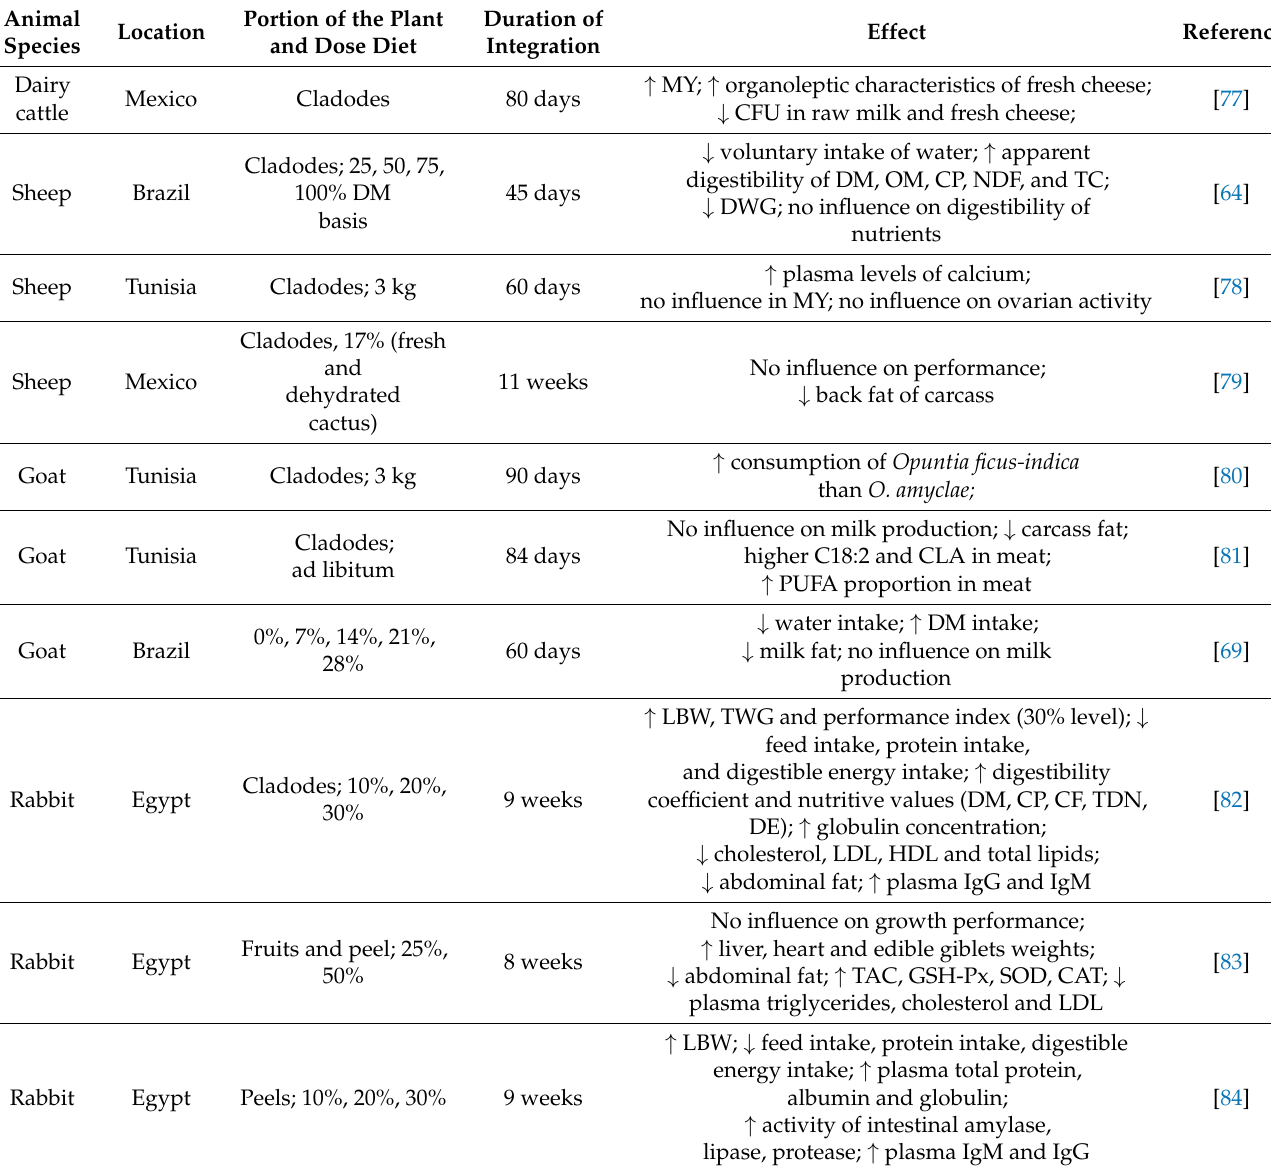
Table 4. Use of O. ficus-indica in animal